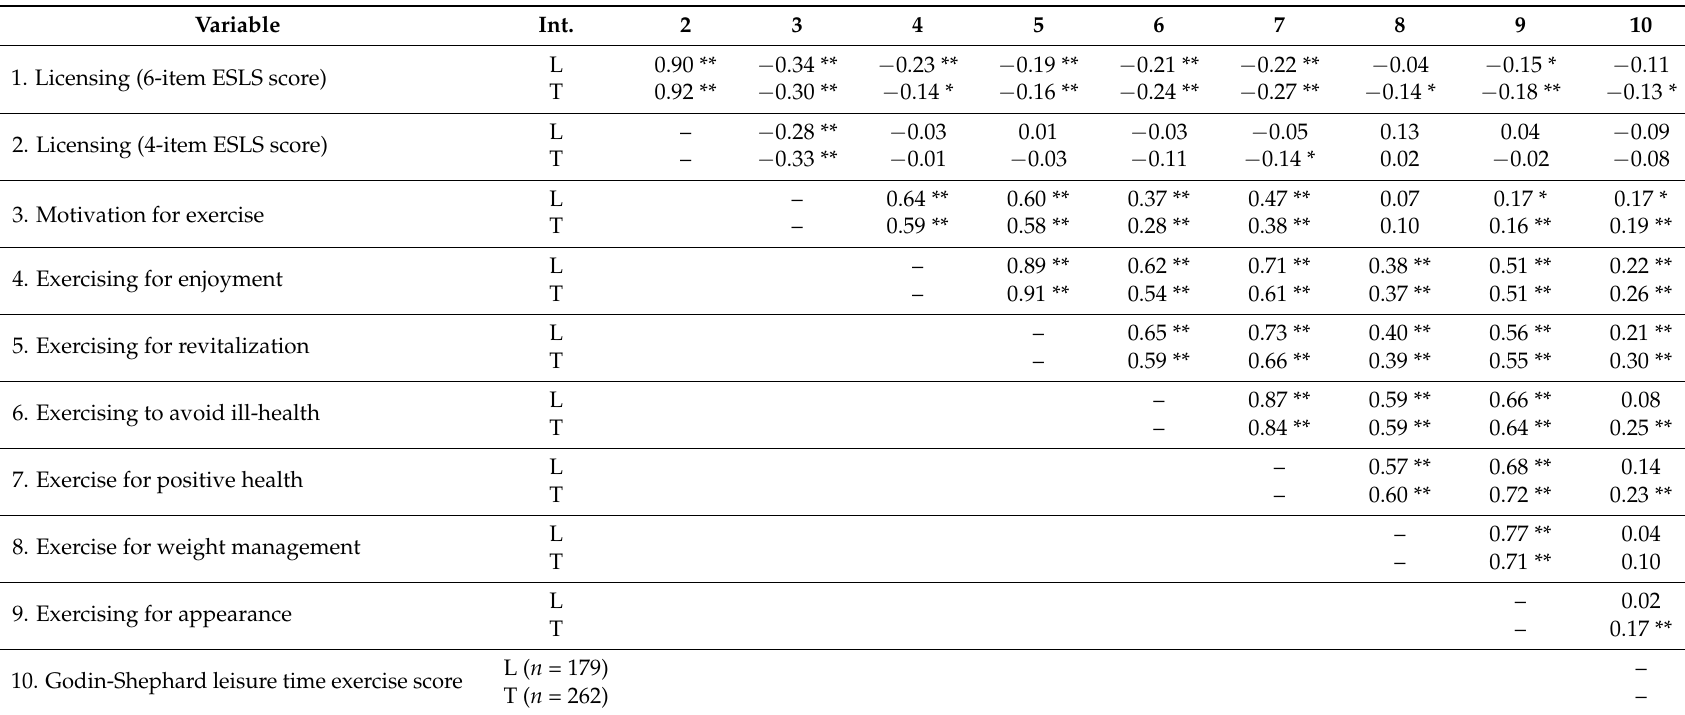
Table 4. Correlations with exercise correlates for four- and six-item versions of “light” ( n = 199) and “tiring” ( n = 297) ESLS. Variable